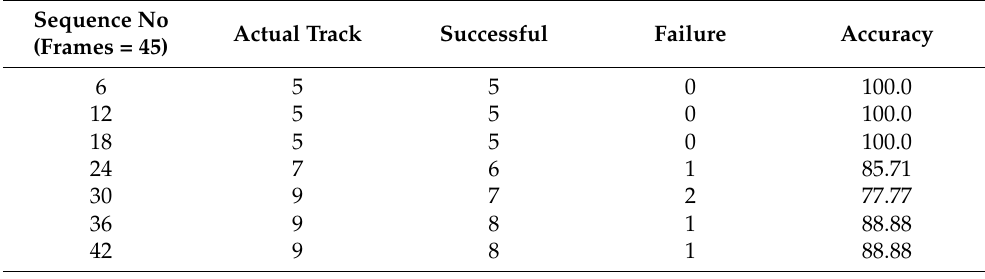
Table 1. Actual human detection and recognition accuracy over avenue